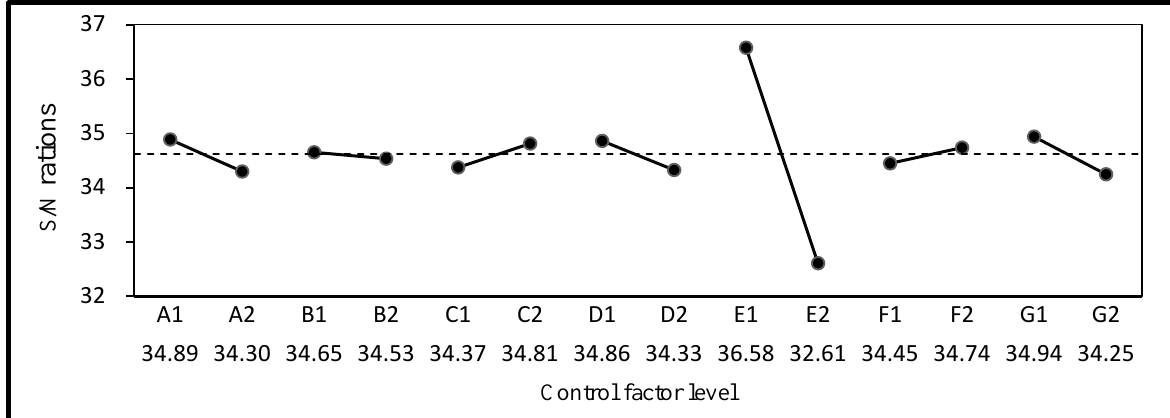
Figure 2. S/N ratio response graph for compressive strength.